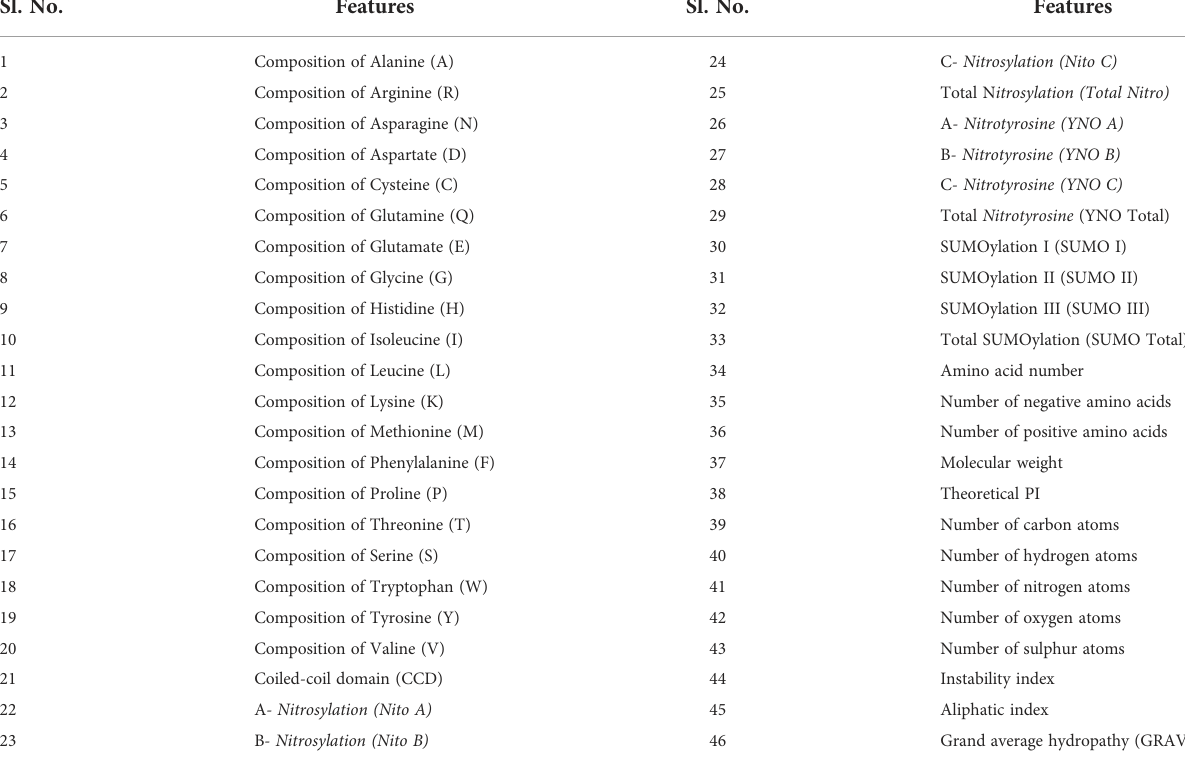
TABLE 1 Set of features under study.